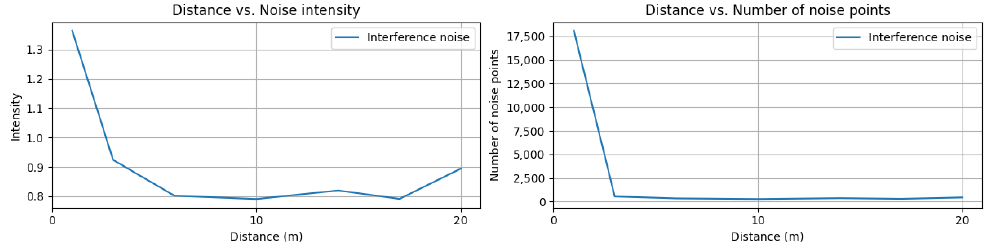
Figure 11. ( Left ) mean intensity of interference noise from a LiDAR sensor faced with the DUT ( Right ) number of LiDAR interference noise per